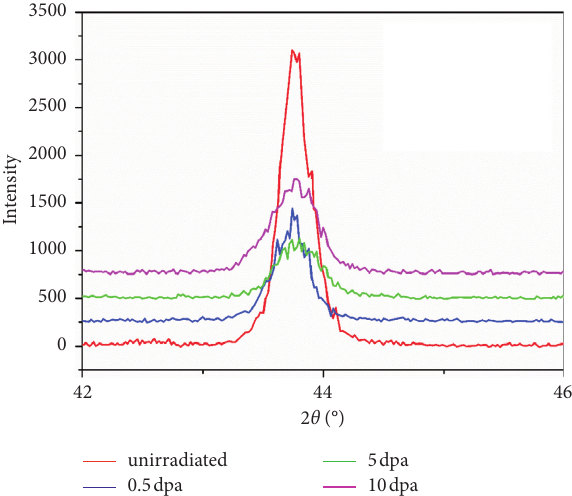
Figure 9: Diffraction pattern of Hastelloy N alloy before and after Xe ion irradiation (enlarged view of the strongest matrix diffraction peak).